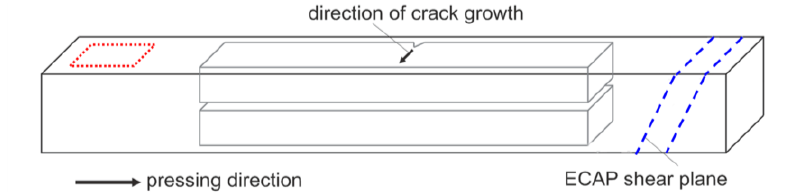
Figure 1. Position of two single-edge-notched bend specimens within the ECAP